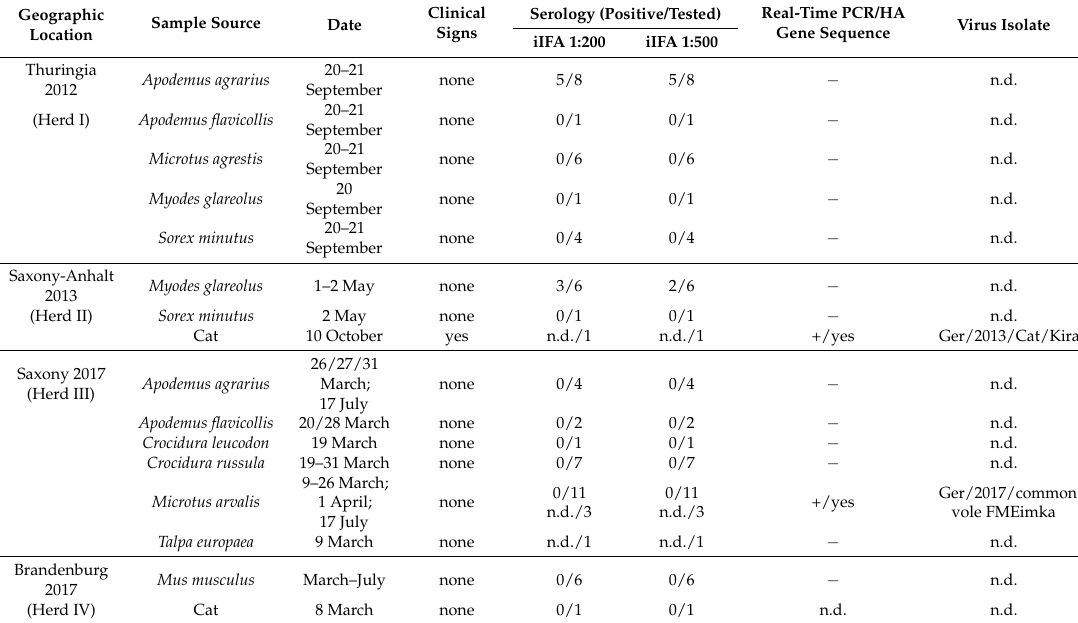
Table 3. Clinical signs and results of cowpox virus investigations (indirect immunofluorescence assay, real-time PCR and virus isolation) in small mammals and cats from four alpaca herds in Eastern Germany.